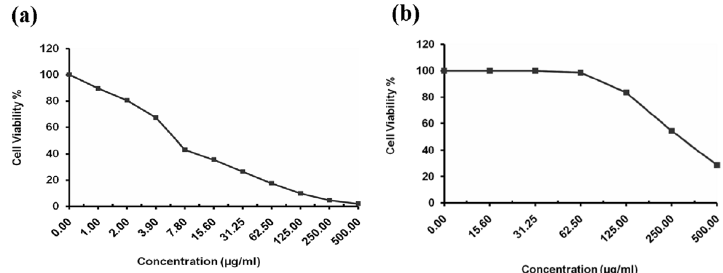
Fig. 6 a Inhibitory activity of purified BVSOD against hepatocellular carcinoma cells. b Inhibitory activity of purified BVSOD against breast carcinoma cells